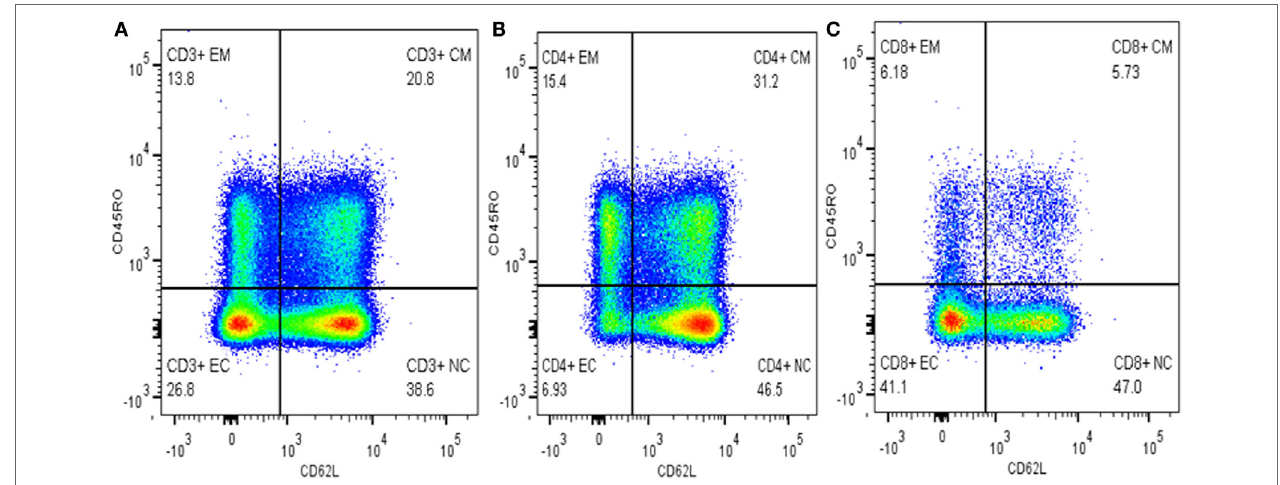
FigUre 1 | Gating memory T-cells on different cell types. (a) Gated on CD3 + T-cells, (B) gated on CD4 + T-cells, and (c) gated on CD8 +